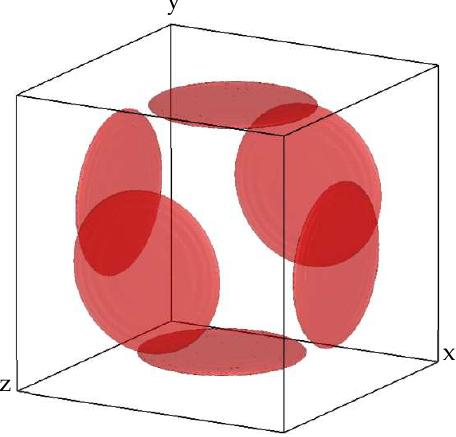
Figure 11. Representation of the 3D configuration of chromium nitride platelets at a volume fraction of 5%.